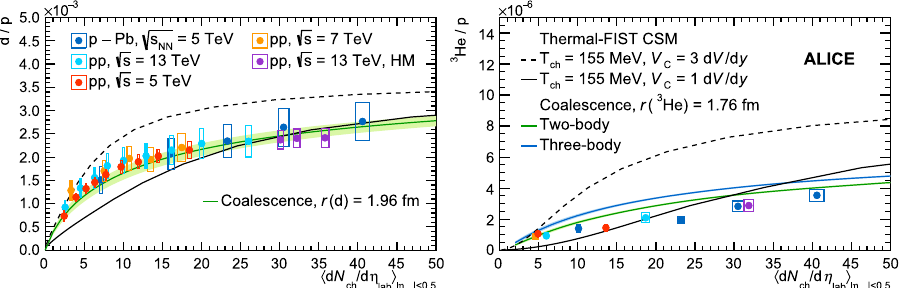
Fig. 5 Ratio between the p T -integrated yields of nuclei and protons as tainties are represented by boxes. The two black lines are the theoretical predictions of the Thermal-FIST statistical model [13] for two sizes of a function of multiplicity for (anti)deuterons (left) and (anti)helions the correlation volume V C . For (anti)deuterons, the green band repre- (right). Measurements are performed in INEL > 0 pp collisions at √ √ s = 5 . 02TeV,inhigh-multiplicityppcollisionsat s = 13TeV[24], sents the expectation from a coalescence model [34]. For (anti)helion, √ √ s = 13 TeV [23,24] and at s = 7 TeV the green and blue lines represent the expectations from a two-body and in INEL > 0 pp collisions at √ s NN = 5 . 02 TeV [11,31]. The statistical three-body coalescence models [6], and in p–Pb collisions at uncertaintiesarerepresentedbyverticalbarswhilethesystematicuncer-